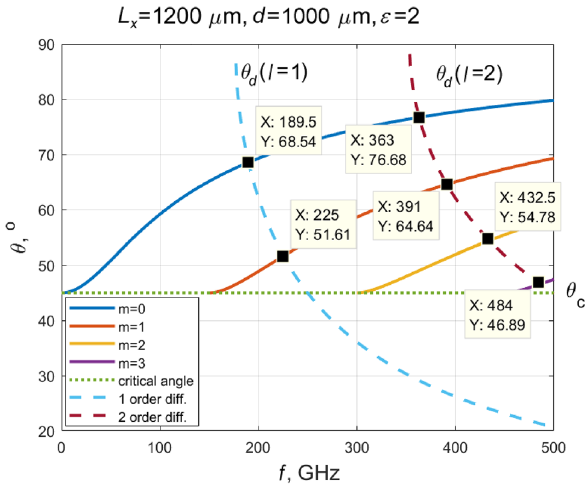
Figure 2. Dependences of the angle, at which light impinges on the dielectric-air interface, on frequency for a dielectric plate in the air. The thickness of the plate d = 1000 μm, its dielectric constant is 2.0, and the grating period L x = 1200 μm. Solid lines show allowed modes in the plate, dashed lines demonstrate diffraction angles, and the dotted line denotes the angle of total internal reflection. The intersection points of solid and dotted lines show modes that can be excited in the plate with a metasurface deposited on its surface, the periodicity of which is L x